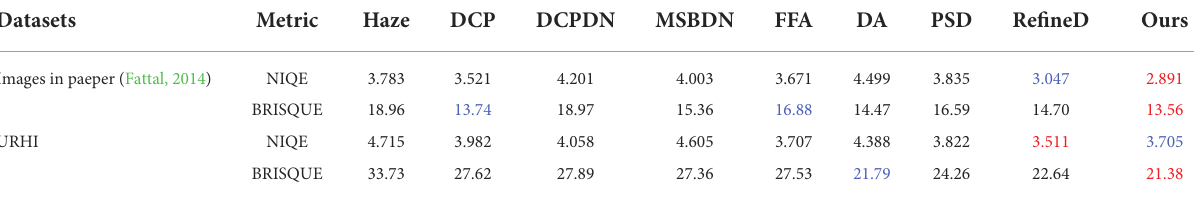
TABLE 4 Quantitative comparison results on the images in paper (Fattal, 2014) and URHI datasets. Datasets Metric Haze Images in paeper (Fattal, 2014)